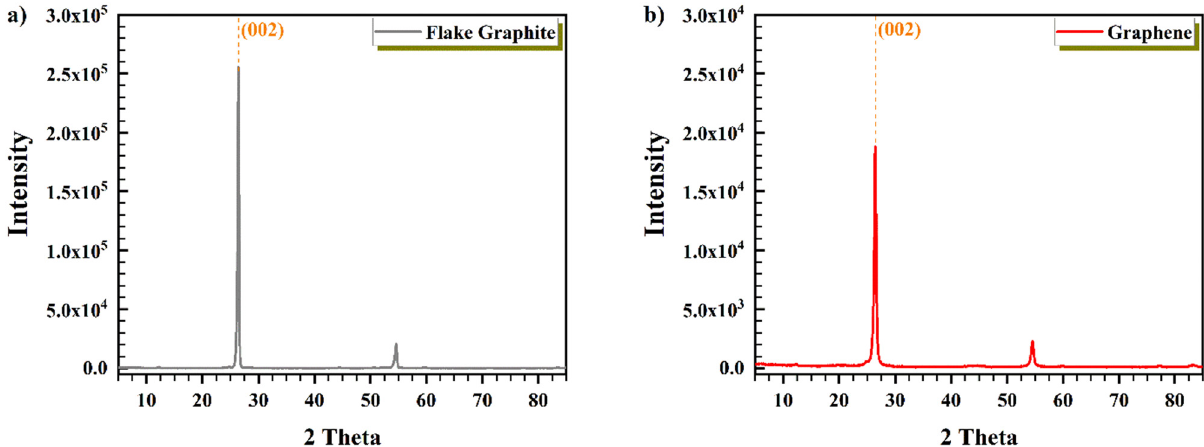
Figure 3: XRD pattern of ( a ) fl ake graphite and ( b ) graphene.